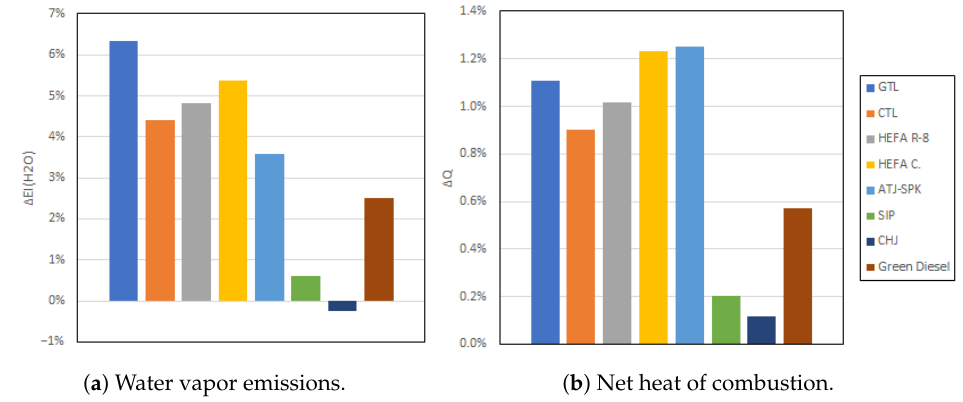
Figure 5. RDs in water vapor emission index and net heat of combustion for SAF blends.